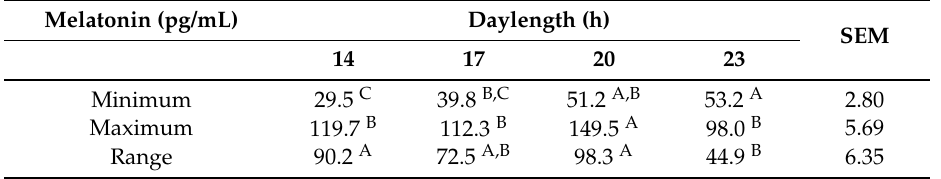
Table 1. The impact of daylength on broiler minimum and maximum daily melatonin levels (pg/mL) and the range between minimum and maximum values